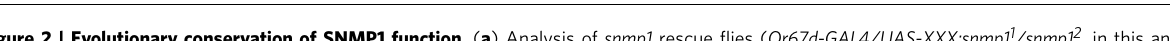
Figure 2 | Evolutionary conservation of SNMP1 function. ( a ) Analysis of snmp1 rescue flies ( Or67d-GAL4/UAS-XXX;snmp1 1 /snmp1 2 , in this and all equivalent rescue experiments) expressing C-terminal EGFP fusions of SNMP1 from D. melanogaster , A. polyphemus and A. mellifera . Left: immunostaining with a -GFP on antennal cryosections. Scale bars, 20 m m. Centre: representative traces of electrophysiological recordings of OR67d neurons in male flies stimulated with 10% cVA. Right: mean neuronal responses ± s.e.m. to the indicated stimuli in each genotype. There are significant statistical differences in neuronal responses to cVA due to genotype (Kruskal–Wallis, P o 0.0001). Significant differences in cVA responses compared with snmp1 (cid:2) / (cid:2) (Fig. 1d) are indicated in the figure; ** P o 0.01, *** P o 0.001. ( b ) Analysis of snmp1 rescue flies expressing M. musculus CD36:EGFP (for immunohistochemistry) or untagged CD36 (for electrophysiology). Left: immunostaining with a -GFP on antennal cryosections. Scale bar, 20 m m. Centre: representative trace of electrophysiological recordings of OR67d neurons in male flies stimulated with 10% cVA. Right: mean neuronal responses ± s.e.m. to the indicated stimuli. There is a significant increase in 10% cVA sensitivity in M. musculus CD36 rescue when compared with snmp1 (cid:2) / (cid:2) (Mann–Whitney test; *** P o 0.001). ( c ) Left: representative traces of electrophysiological recordings of OR67d neurons in a close-range stimulation assay with 10% cVA in the indicated genotypes. The grey arrows indicate the approximate time of closest stimulus position to the sensillum. Right: mean neuronal responses ± s.e.m. in each genotype. There are significant statistical differences in neuronal responses due to genotype (Kruskal–Wallis, P o 0.0001). Significant differences in cVA responses of the different genotypes compared with snmp1 (cid:2) / (cid:2) are indicated in the figure; * P o 0.05, ** P o 0.01 and *** P o 0.001. ( d ) Left: representative traces of electrophysiological recordings of OR67d neurons lacking OR67d and SNMP1, and ectopically expressing the moth pheromone receptor HR13 in the absence or presence of CD36 and SNMP1, stimulated with 10% ( Z )-11-hexadecenal. Genotypes: ‘HR13’, UAS-HR13;Or67d GAL4 ,snmp1 1 /Or67d GAL4 ,snmp1 2 ); ‘HR13 þ CD36’, UAS-HR13/UAS-CD36;Or67d GAL4 ,snmp1 1 /Or67d GAL4 ,snmp1 2 ); and ‘HR13 þ SNMP1’, UAS-HR13/UAS-SNMP1;Or67d GAL4 ,snmp1 1 /Or67d GAL4 ,snmp1 2 . Right: mean neuronal responses ± s.e.m. in each genotype. There are significant statistical differences in neuronal responses to ( Z )-11-hexadecenal due to genotype (one-way analysis of variance, P o 0.0001). Significant differences in cVA responses compared with ‘HR13’ are indicated in the figure; ** P o 0.01, *** P o